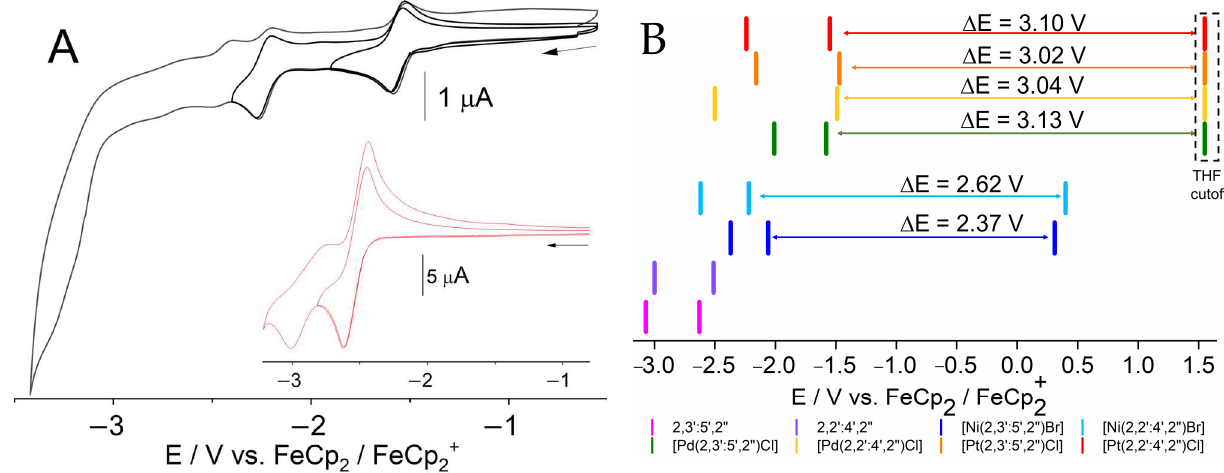
Figure 4. ( A ) Cyclic voltammograms of [Pt(2,2′:4′,2″-terpy)Cl] ( Pt-1-Cl ) (black trace) and 2,2′:4′,2″- terpy (red trace) in 0.1 M n- Bu 4 NPF 6 /THF solution at 298 K and a scan rate of 100 mV/s. ( B ) Summa- rised selected redox potentials (full data in Table S3).